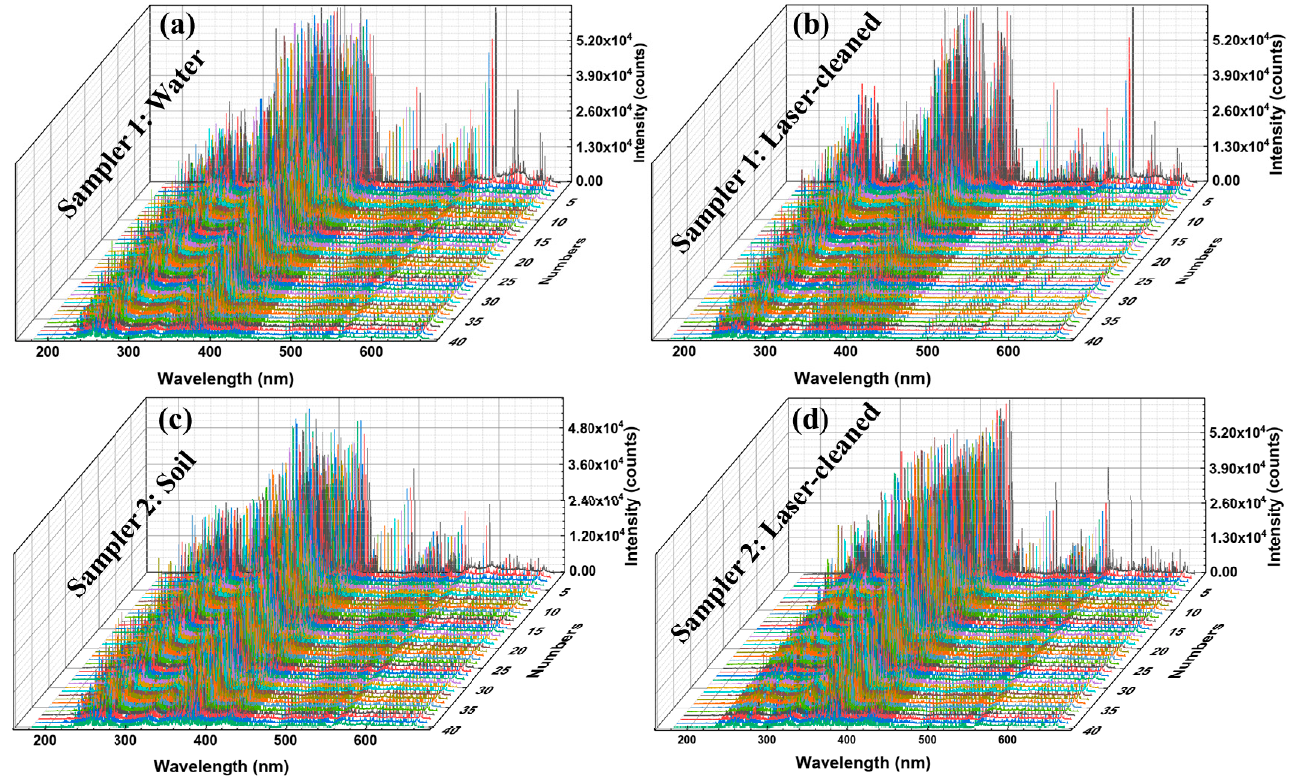
Figure 3. LIBS spectra (40 excitations), ( a ) Sample 1: contaminated with water, ( b ) Sample 1: laser-cleaned, ( c ) Sample 2: contaminated with soil, and ( d ) Sample 2: laser-cleaned.